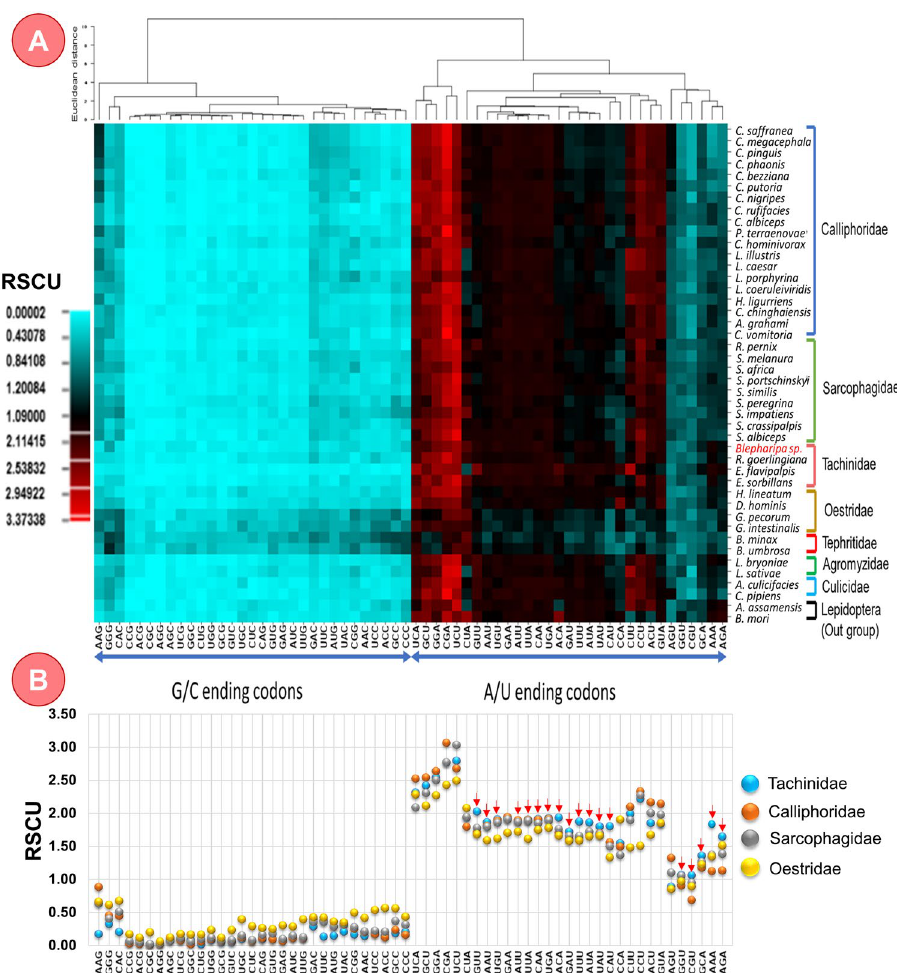
Figure 5. Variation of Relative synonymous codon usage (RSCU) in different species and families; ( A ) RSCU Cluster analysis of 36 species from Oestroidea Superfamily, 6 organisms from other Diptera and 2 organisms from out group (Lepidoptera). Termination codons are excluded. The heat-map was drawn with CIMminer. Bigger RSCU values, suggesting more frequent codon usage, are represented with darker shades of red. ( B ) Mean RSCU of different families of Oestroidea superfamily, higher RSCU of tachinids denoted by red